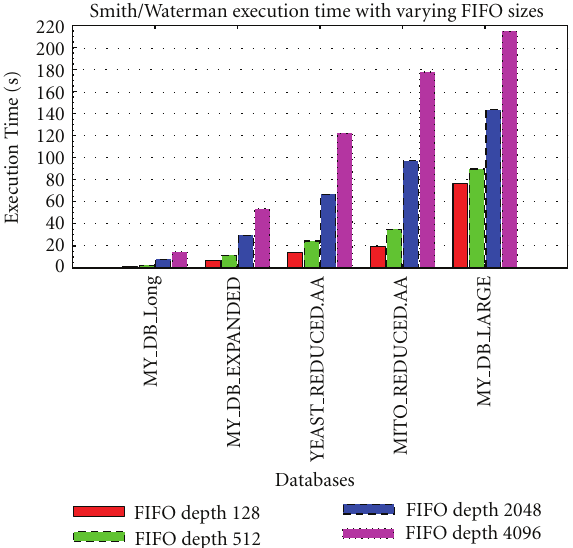
Figure 13: Smith/Waterman’s performance with varying FIFO depths.